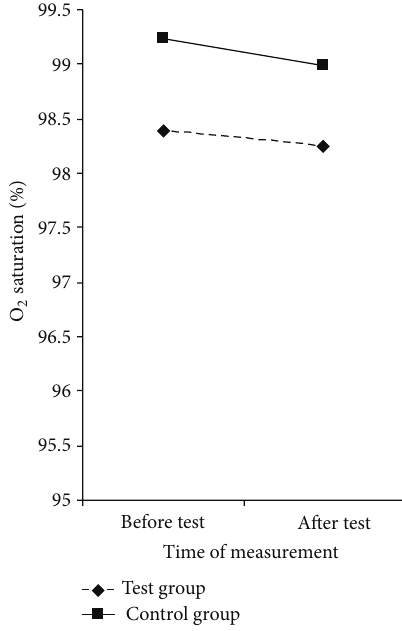
Figure 2: Presentation of the groups studied compared to the value of oxygen saturation before and after the